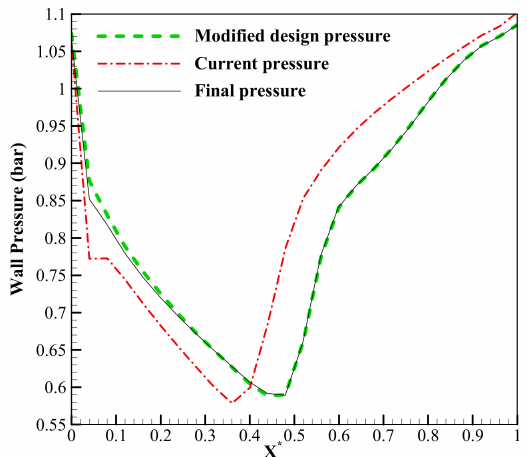
Figure 18. Current, final and modified design pressure distributions versus non-dimensionalized X*—coordinate, for the second design of the suction side of a transonic blade by UESA with applying the spine constraint and E distribution applied.